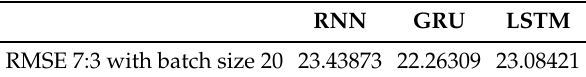
Table 3. Algorithm